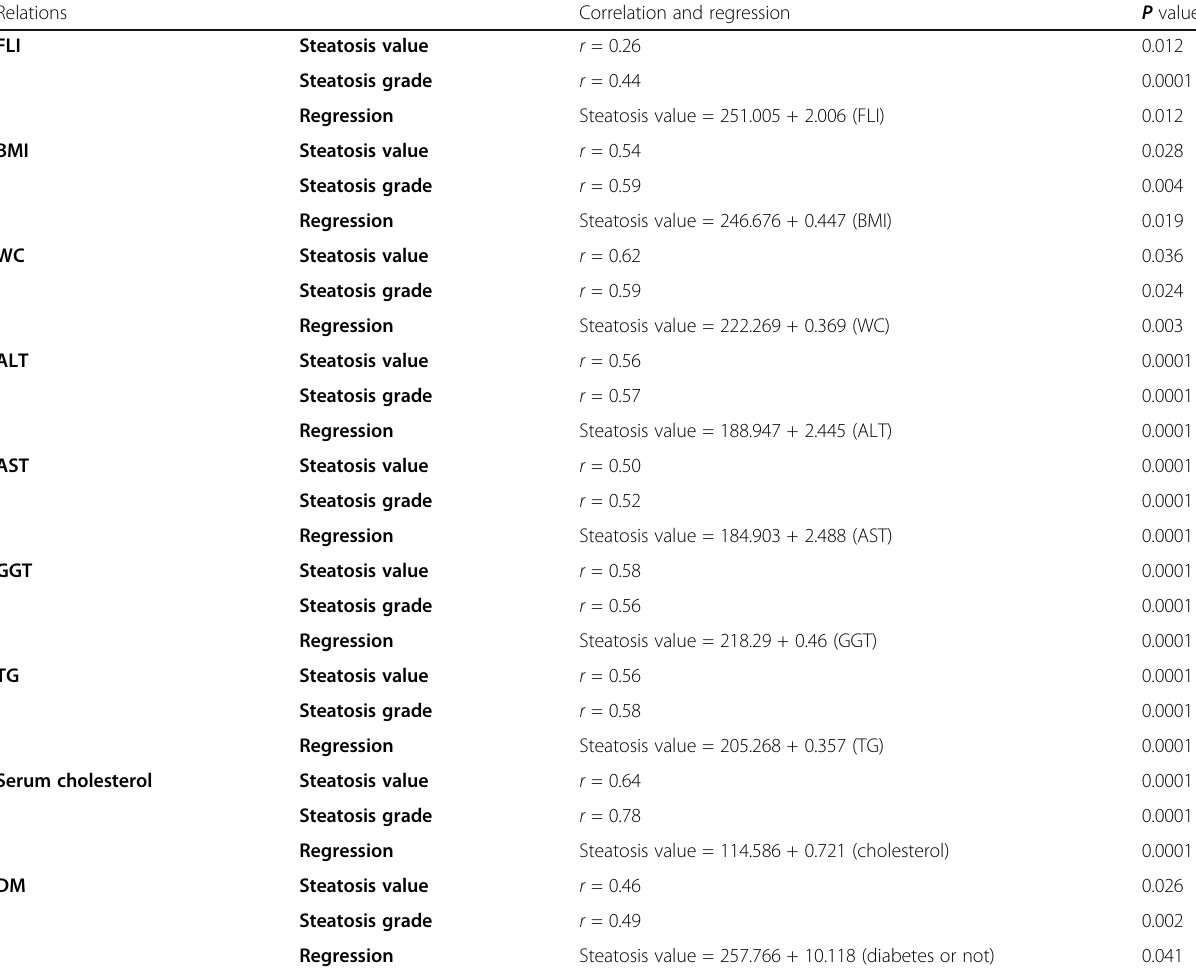
Table 3 Correlation and regression between steatosis grades by CAP and different non-invasive parameters for liver steatosis